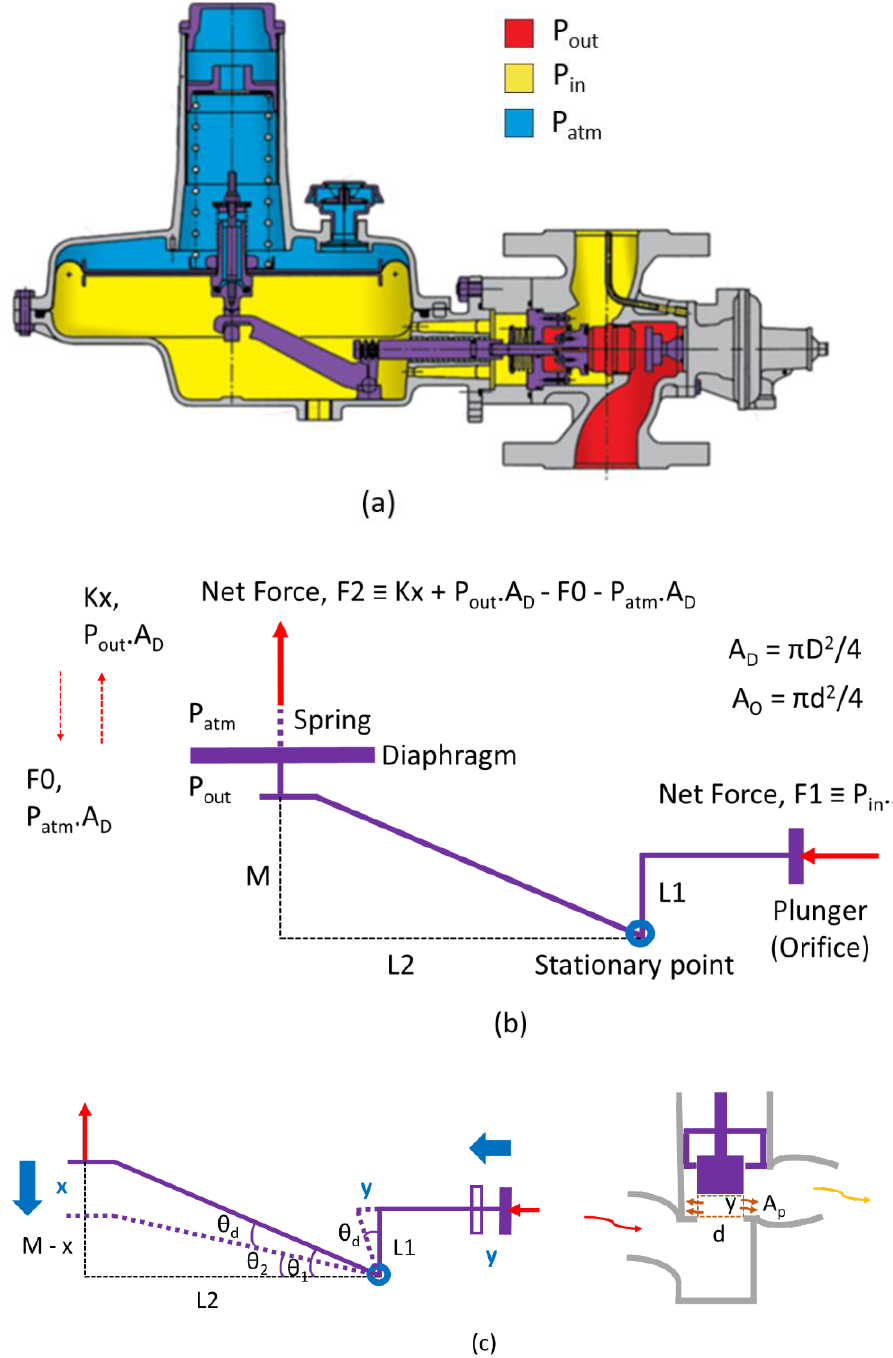
Figure 3. ( a ) A schematic of the HON 277 gas PR, ( b ) the torque balance for the lever-type PR (HON 277), and ( c ) the computation of the displacement of the lever and flow area.